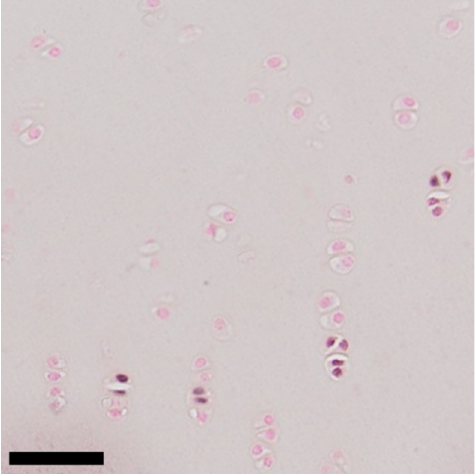
Fig 1. Immunohistochemical staining of chondrocytes with nuclear fast red counterstain for detection of Ki-67 expression. Chondrocytes with darker nuclei are positive for Ki-67 expression. Bar indicates 50 micrometers.